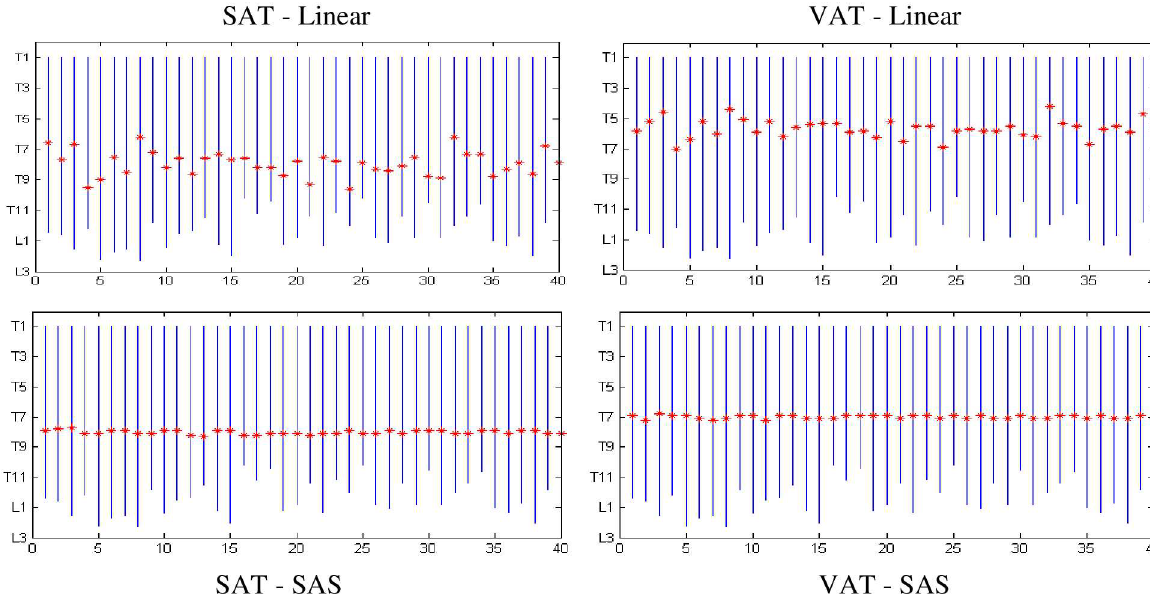
Fig 5. Best slice location found by linear mapping (top row) and SAS mapping (bottom row) for SAT (left) and VAT (right) shown by " * " for each subject.